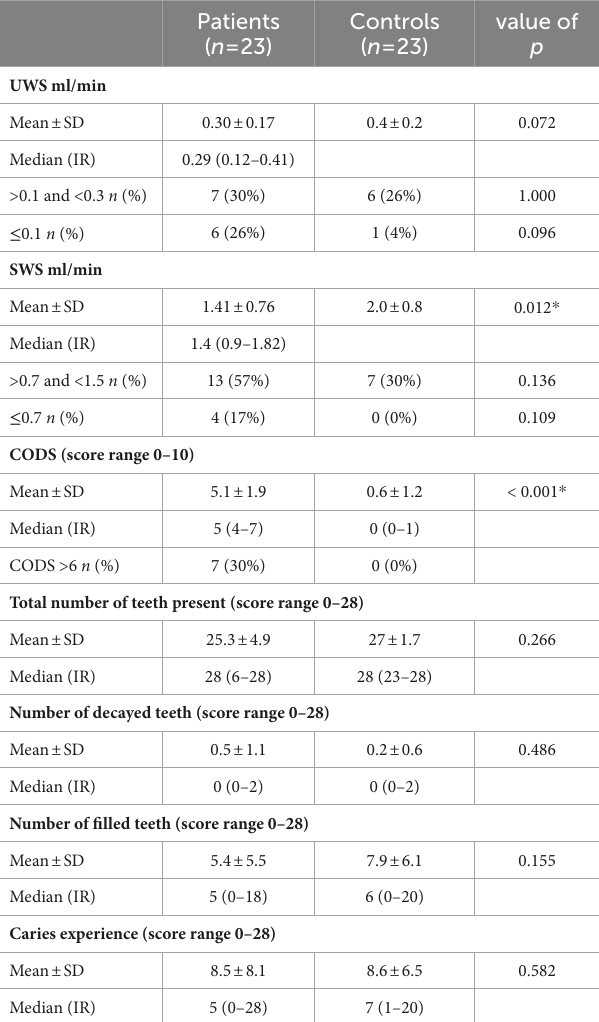
TABLE 5 Shortened xerostomia inventory (SXI) scores and frequency of complaints for each question, presented as mean ± SD, median (interquartile range, IR), and number of cases